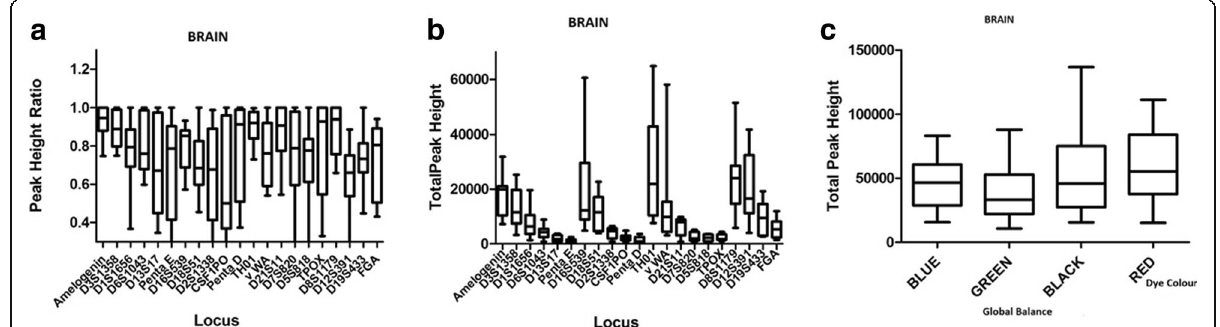
Fig. 5 Profile quality parameters for brain tissue samples. a Peak height ratio. b Total peak height. c Global balance